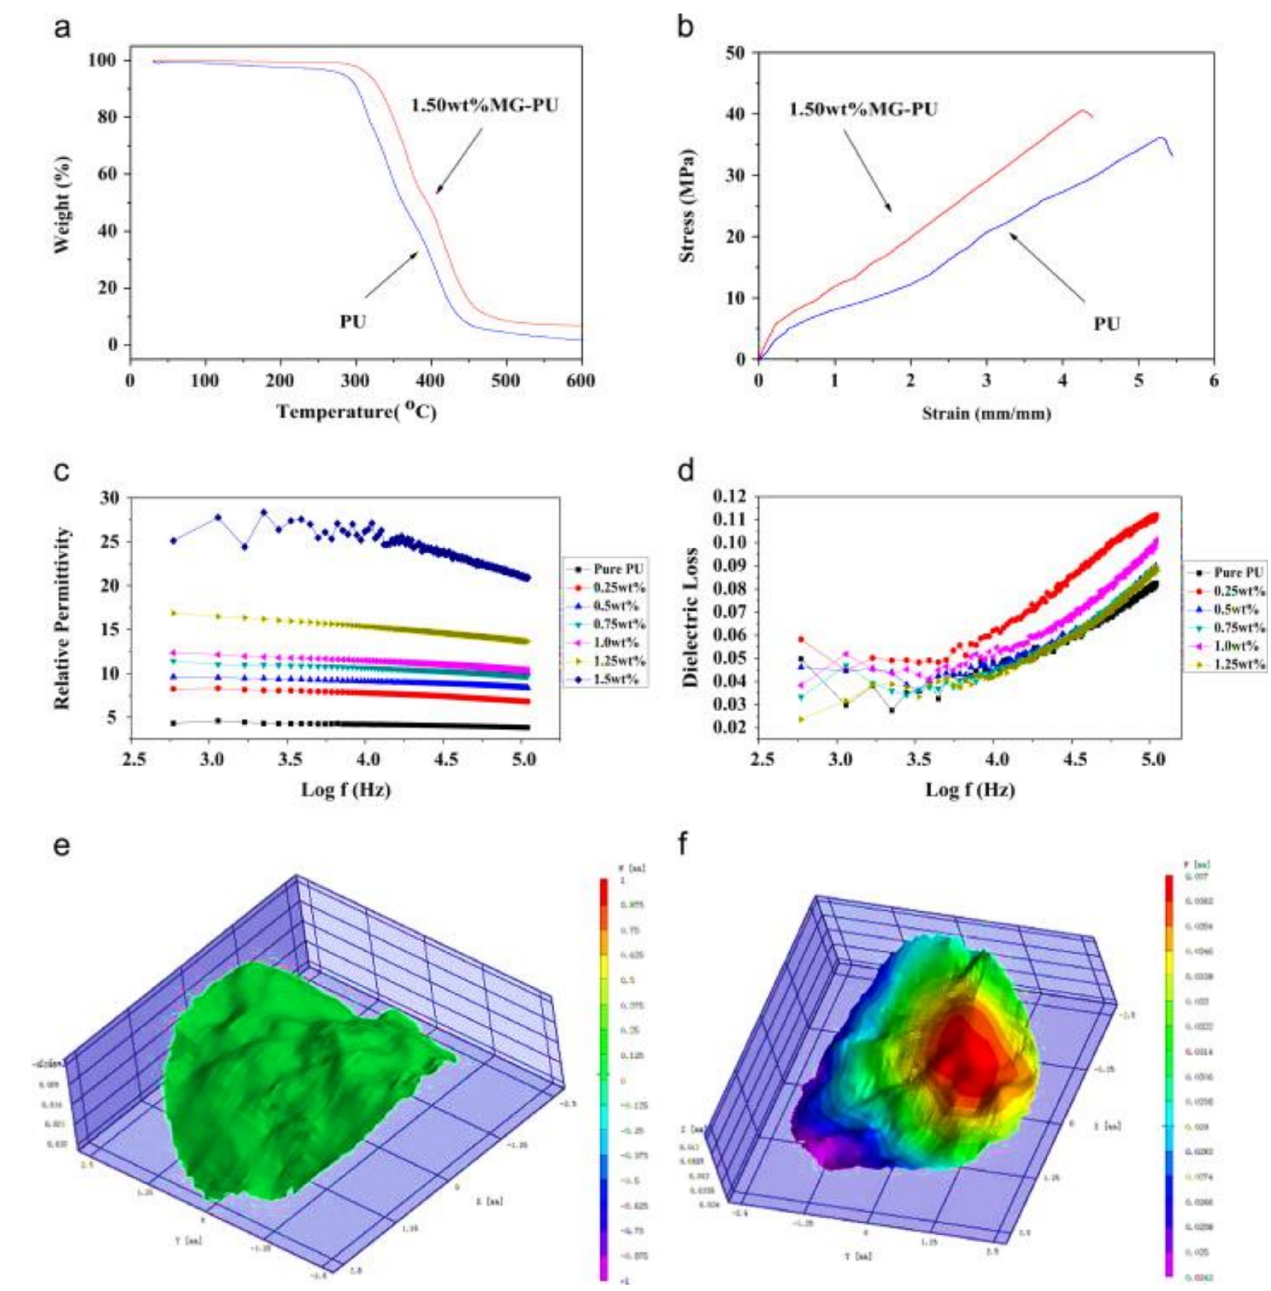
Figure 9. DTA curve ( a ). Load-deflection curves; ( b ) of Polyurethane and 1.5 wt. percent poly(methylmethacrylate) function- alized graphene–polyurethane, dielectric-constant; ( c ) and dielectric-loss; ( d ) of poly(methylmethacrylate) functionalized graphene–polyurethane composites, electrical field induced strain-nephograms; (( e ) Voltage-off, ( f ) Voltage-on) of 1.50 wt. percent poly(methylmethacrylate) functionalized graphene–polyurethane composite film. Reproduced with permission from